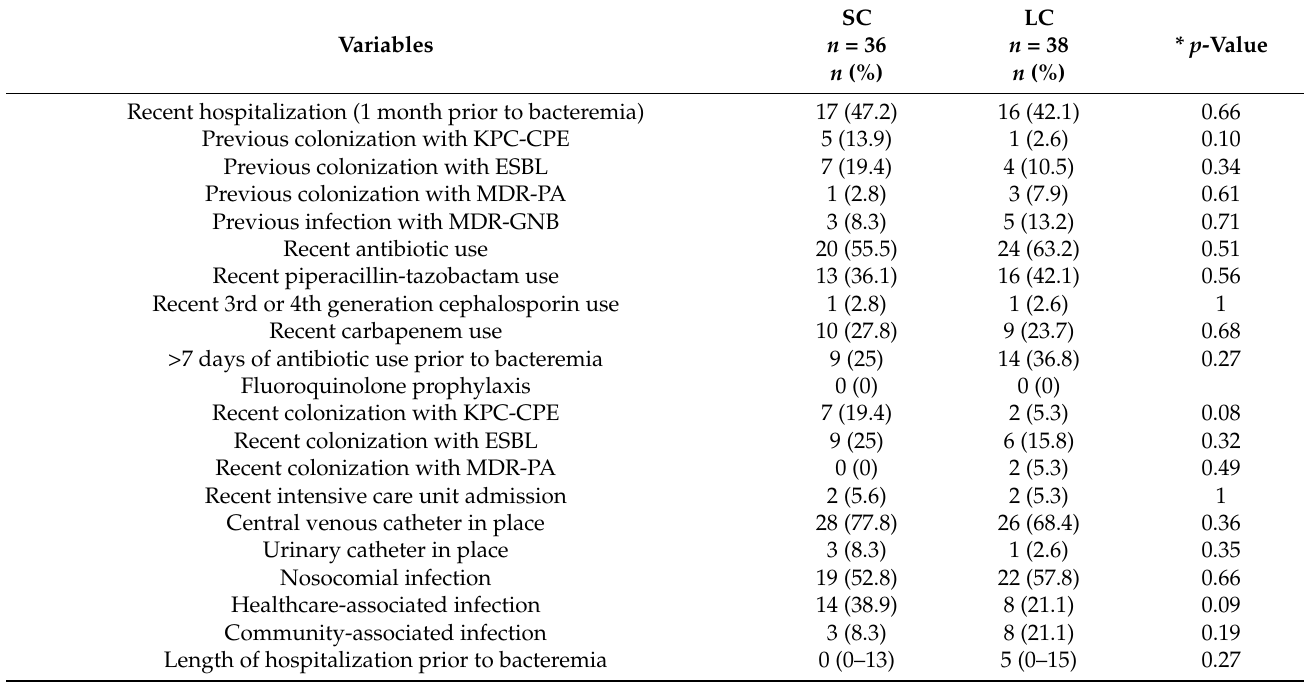
Table 2. Epidemiological findings of Gram-negative bacteremia treated with SC or LC of antibiotic therapy.